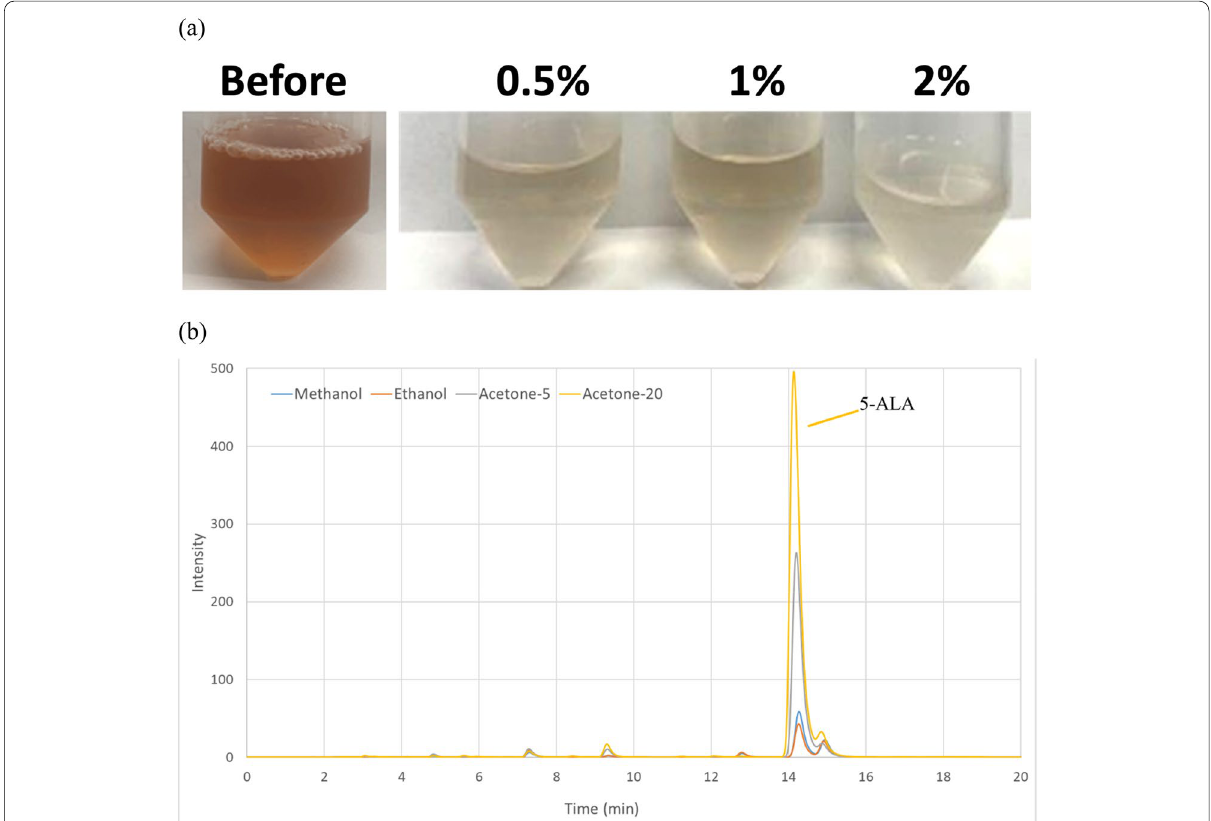
Fig. 2 (a) Decolorization of 5‑ALA after IEC using 0.5%, 1% and 2% activated carbon. ( b) The HPLC result for 5‑ALA precipitation from different the parentheses